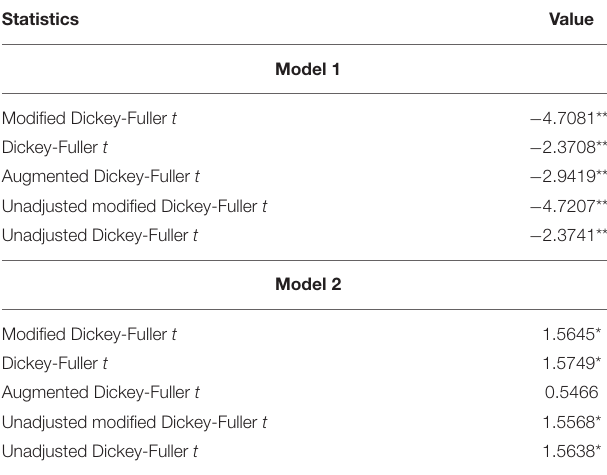
TABLE 6 | Cointegration results